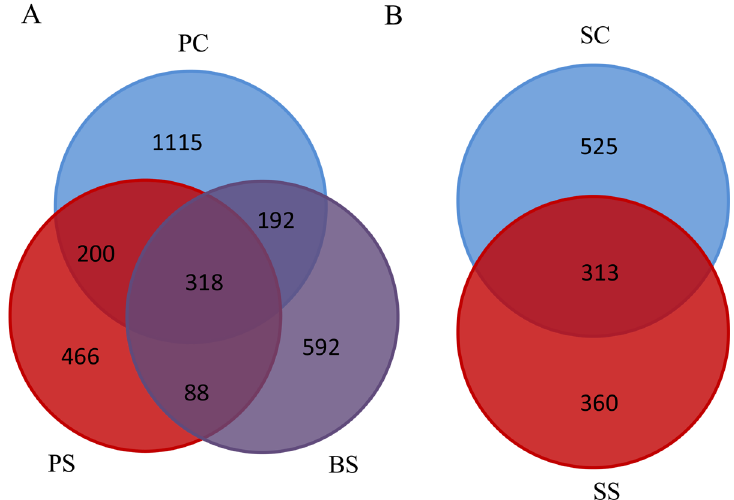
Fig 4. Venn diagram of the number of OTUs common/unique to the black stain and control groups. The overlapping areas represent the number of OTUs shared by the counterpart samples. A: A total of 2971 OTUs were detected in black stain (BS) and the dental plaque of the black stain group (PS) and control group (PC). Only 318 OTUs were shared by PS, PC and BS, while 1115, 466, and 592 OTUs were unique to the respective groups. B: A total of 1198 OTUs were detected in the salivary samples of the black stain group (SS) and control group (SC). Only 313 OTUs were shared by the SC and SS groups, and 525 and 360 OTUs were unique to the respective